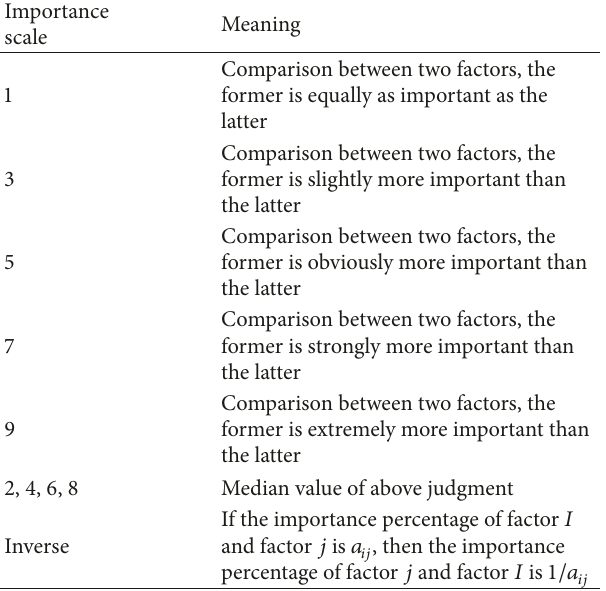
Table 5: The Importance scale.